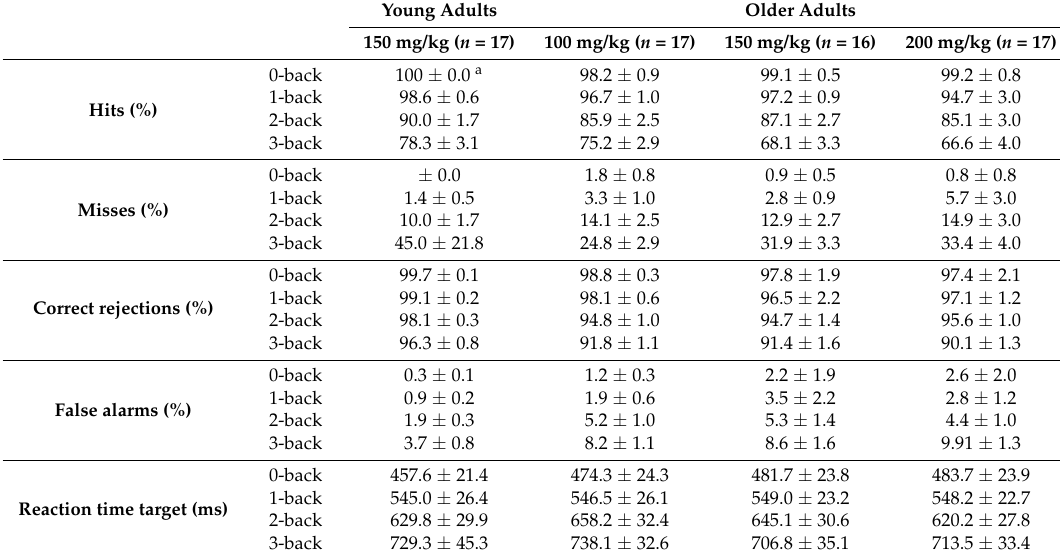
a Values are mean ± SEM (Standard Error of the